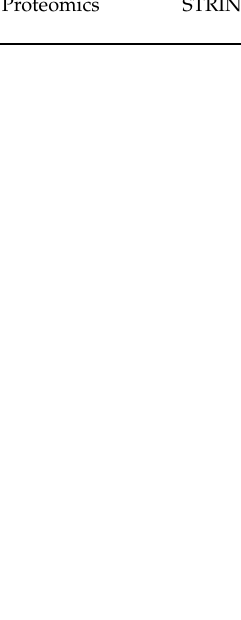
Table 2. Major networks used in psychiatric disorder